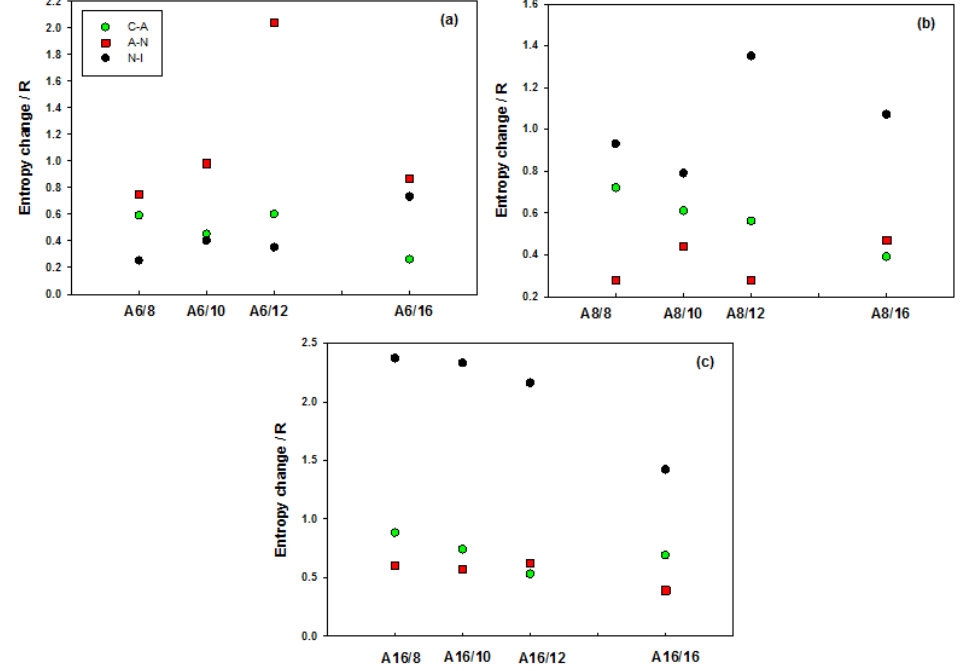
Figure 5. Normalized entropy changes as a function of alkoxy chain length m for SMHBCs An / Im ; ( a ) n = 6; ( b ) n = 8 and ( c ) n = 16; C-A = smectic C to smectic A transition; A-N = smectic A to nematic phase transition; N-I = nematic to isotropic liquid transition.